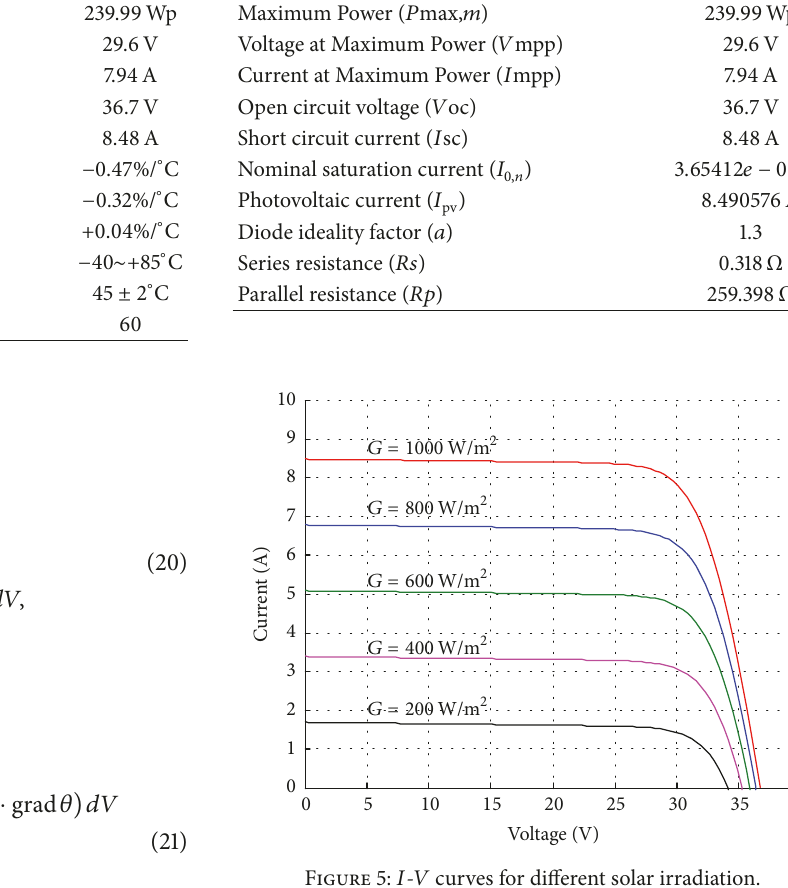
Figure 5: 𝐼 - 𝑉 curves for different solar